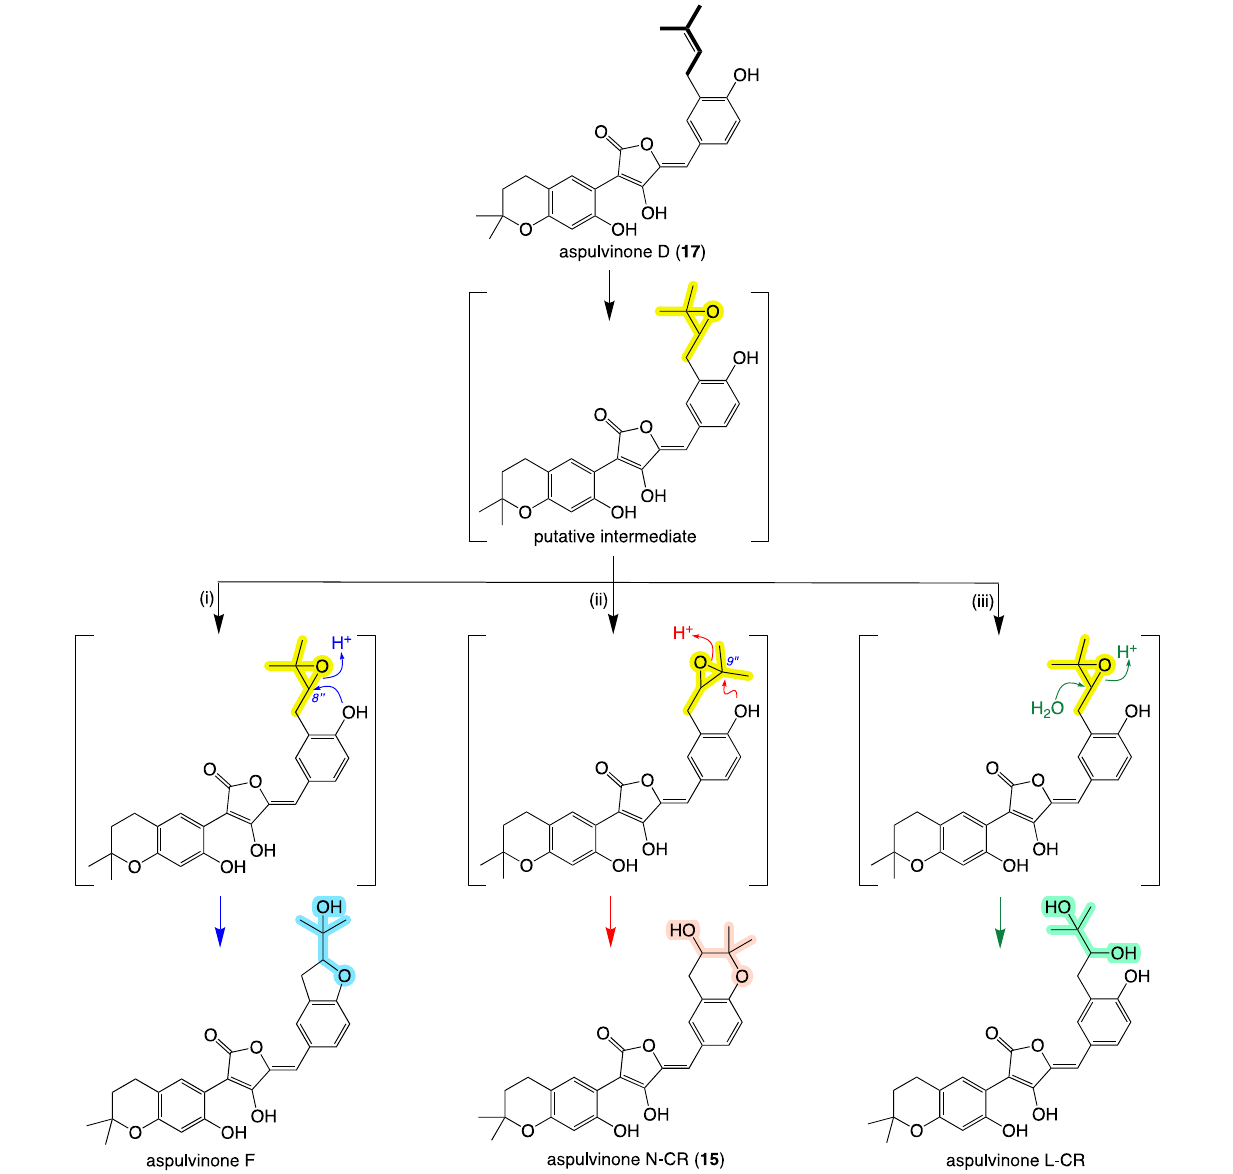
Figure 12. A plausible biogenetic relationship linking prenylated to hydroxylated and heterocyclic aspulvinones (i–iii three different pathways to yield various aspulvinone analogs). Highlighted (bold, yellow, blue, red, green) indicate biogenetically related residues.